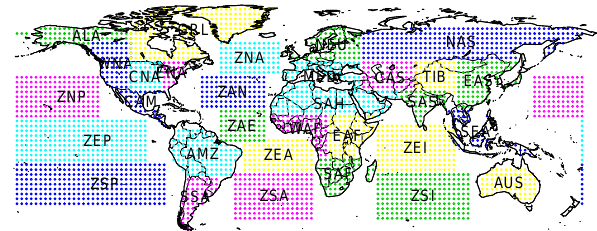
Figure 3. Region definitions (Giorgi and Francisco, 2000).